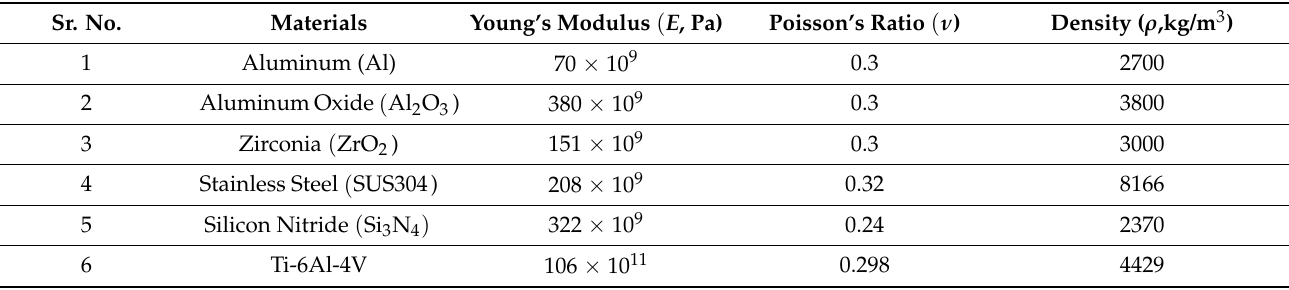
Table 1. Material properties of different FGM plates